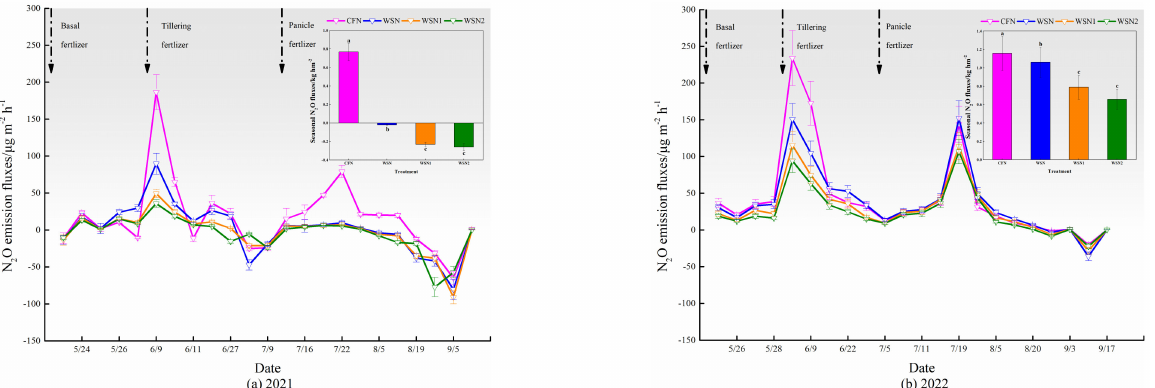
Figure 3. N 2 O emission fluxes and seasonal N 2 O fluxes during the rice cropping season in ( a ) 2021 and ( b ) 2022. Bars represent means SE. Different letters indicate significant differences ( p < 0.05) between different treatments.